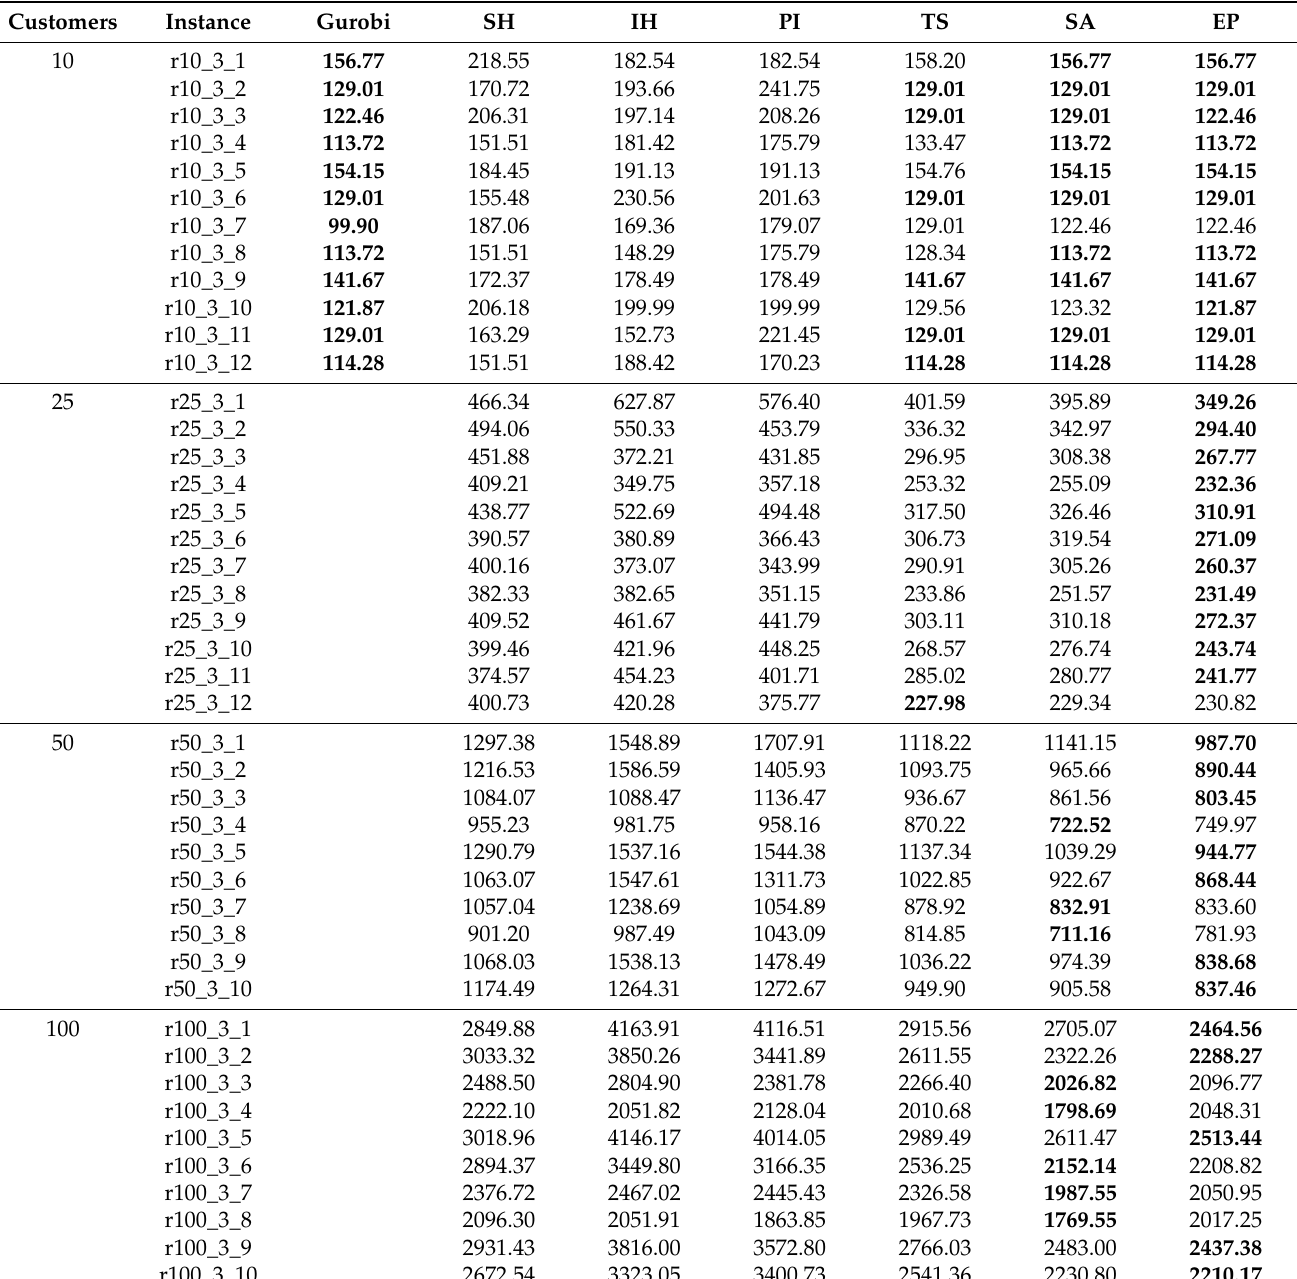
Table 2. Comparison of solution